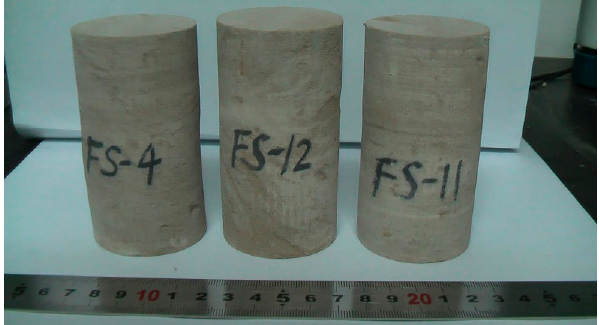
Figure 9. Sandstone samples used in this study reaches the saturation state at the end of the experi- ment.